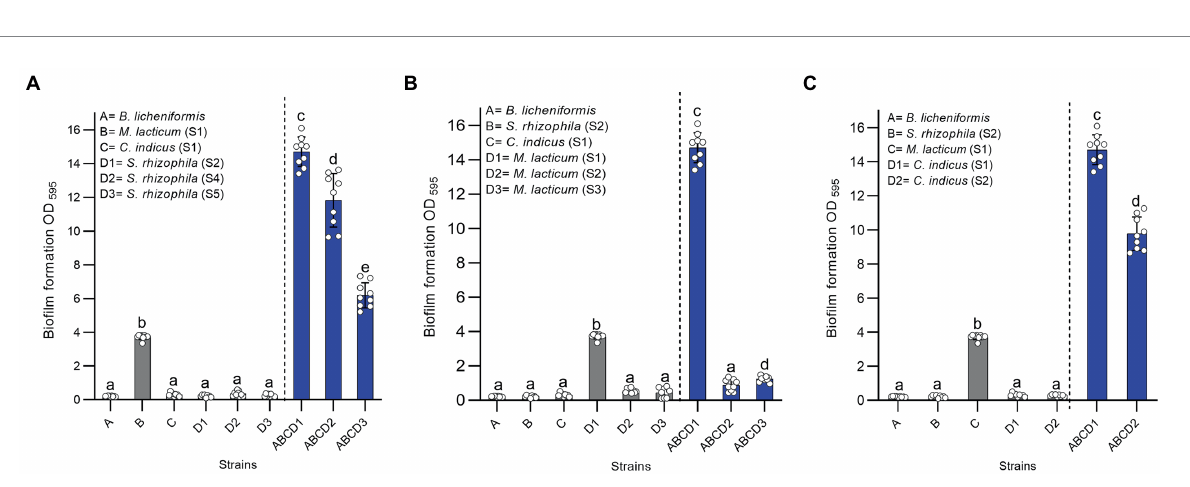
FIGURE 7 Role of different strains of members of a four-species biofilm community in the overall synergy. (A) shows differential influence of three strains of Stenotrophomonas rhizophila (S2, S4, and S5) on the synergy observed in the mixed-species biofilm community. (B) shows the influence of different strains (S1, S2, and S3) of Microbacterium lacticum on the synergy observed in the four-species biofilm. (C) shows the influence of two strains (S1, S2) of Calidifontibacter indicus on the synergy observed in the four-species biofilm. Lower case letters above bars indicate significant differences among biofilm mass of single and mixed species biofilms that were calculated using one-way ANOVA with Duncan’s post hoc test ( p < 0.05 for